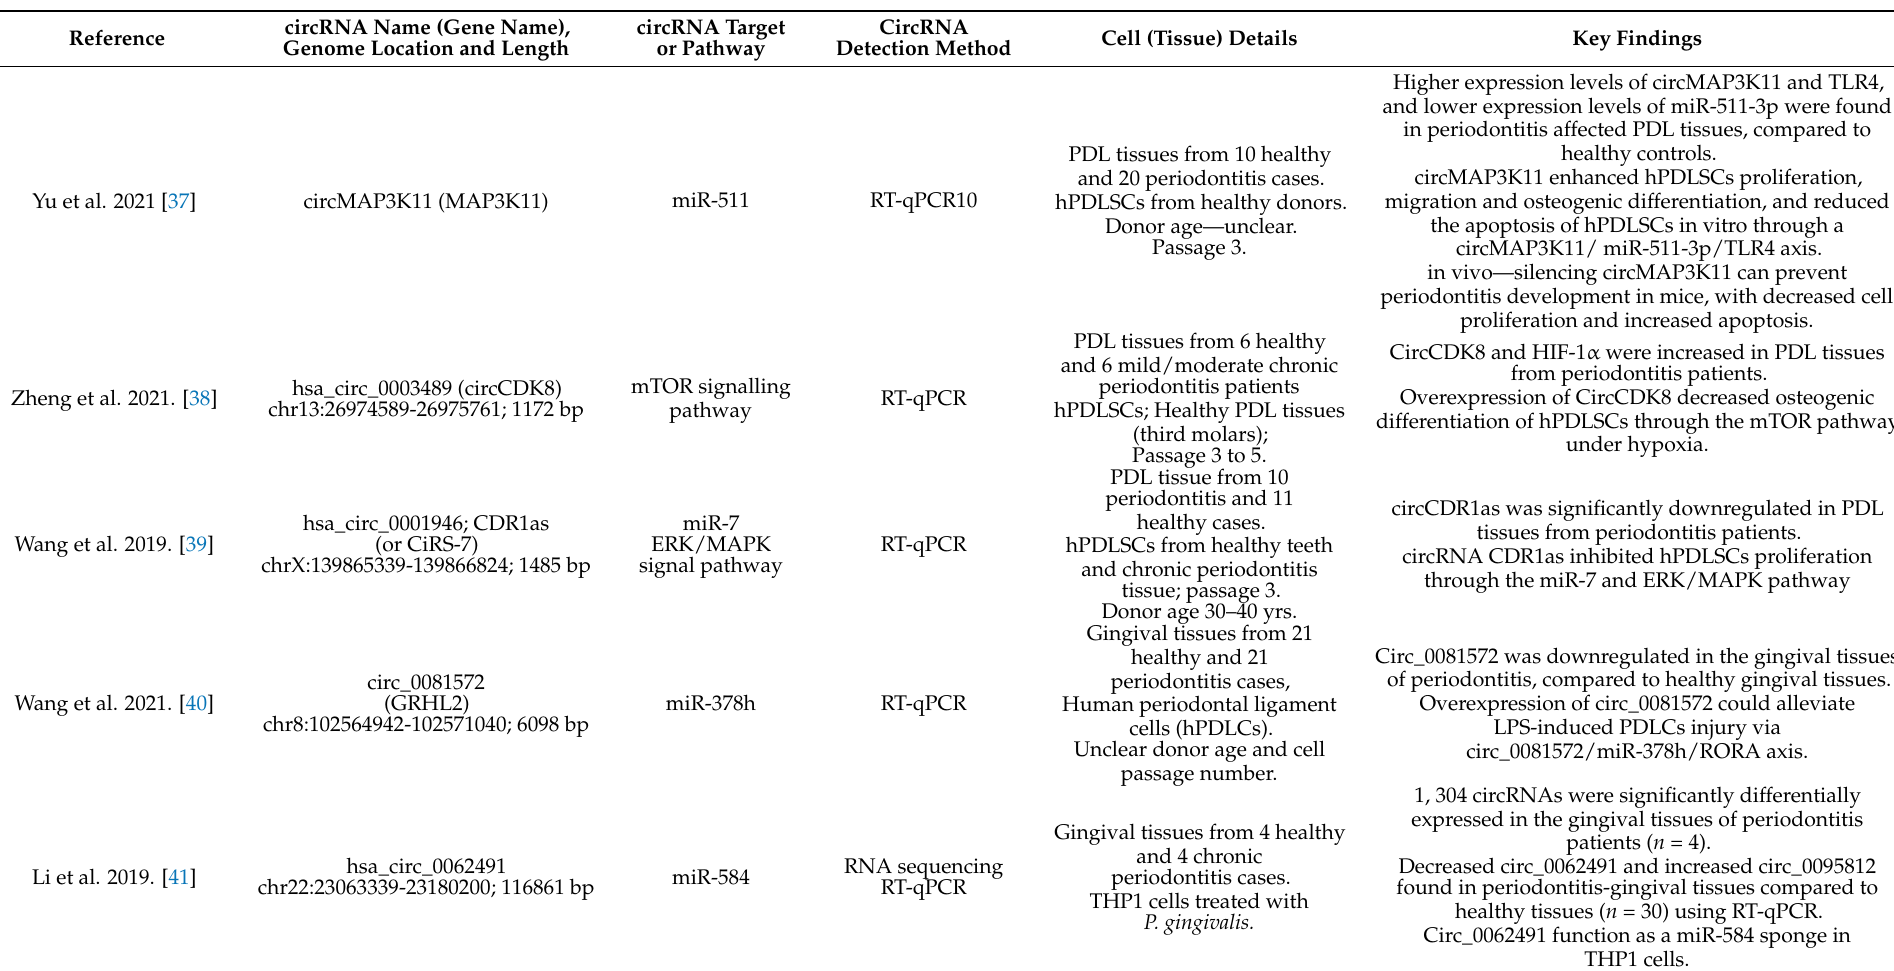
Table 1. Expression of circRNAs in PDL (and cells) and gingival tissues.